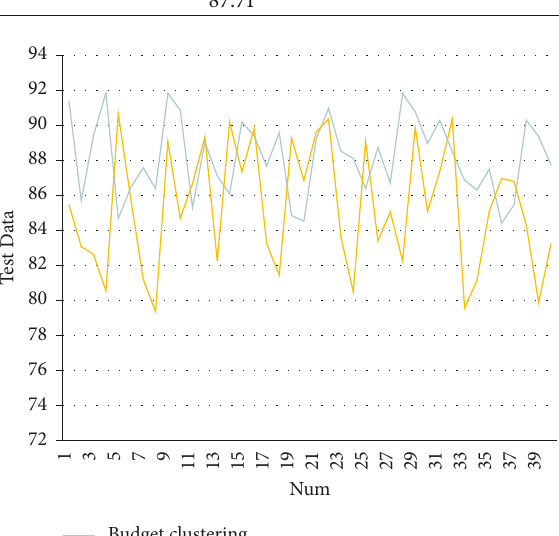
Figure 8: Statistical diagram of the budget control effect of the construction project cost budget control system based on the dynamic distributed clustering